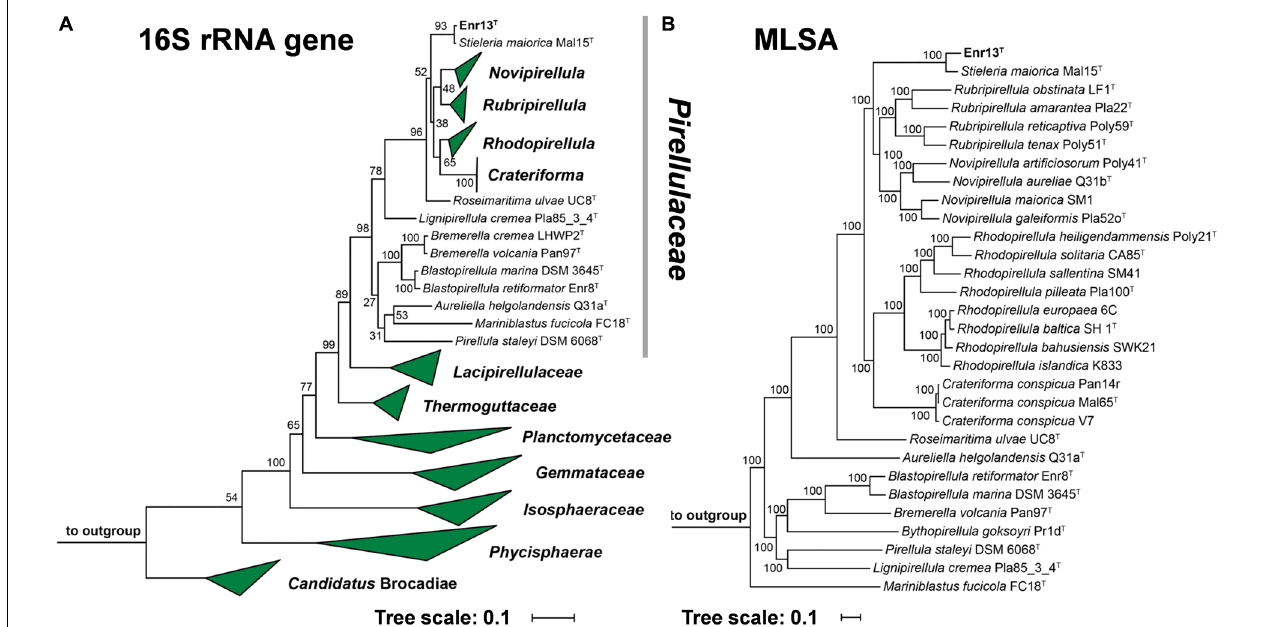
FIGURE 1 | (A) 16S rRNA gene sequence- and MLSA-based phylogenetic trees showing the position of strain Enr13 T . Phylogeny was computed using the maximum likelihood method. Bootstrap values after 1000 re-samplings (16S rRNA gene)/500 re-samplings (MLSA) are given at the nodes (in %). (B) The outgroup of the 16S rRNA gene sequence-based tree consists of three 16S rRNA genes from species outside of the phylum Planctomycetes , but part of the PVC superphylum. Two species of the family Planctomycetaceae ( Planctopirus limnophila and Gimesia maris ) served as outgroup in the MLSA-based